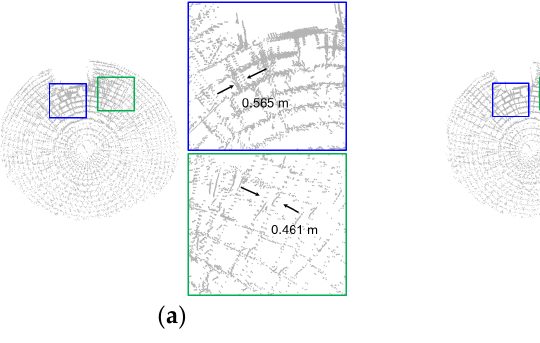
( c ) Figure 39. Extracted edge points from the scans in the Frankfort dataset showing the radial alignment of the stringer rings after the: ( a ) partial fine registration using the roof feature, ( b ) partial fine regis- tration using the ground/wall features, and ( c ) full fine registration using the roof/ground/wall features. Table 5 reports the RMS of the fitting errors after partial fine registration using the roof feature, partial fine registration using the ground/wall features, and full fine registra- tion using the roof/ground/wall features. By inspecting the numerical values for the roof feature in this table, one can see that the partial fine registration and full fine registration using the roof and roof/ground/wall features show similar alignment quality (roughly 5 cm). The partial fine registration using the ground/wall features, on the contrary, produces more misalignment in the range of 9 cm. This should be expected, as the ground/wall features do not provide control for removing misalignment in the direction parallel to the entrance walls. For the ground and wall features, both the partial fine registration using ground/wall features and full fine registration using roof/ground/wall features produce comparable alignment quality, which is also expected. Table 5. RMS of the fitting error for the registration primitives in the Frankfort dataset after partial fine registration using the roof feature (partial 1), partial fine registration using the ground/wall (par- tial 2) features, and full fine registration using the roof/ground/wall features. Roof Quality of Fit Number of Points